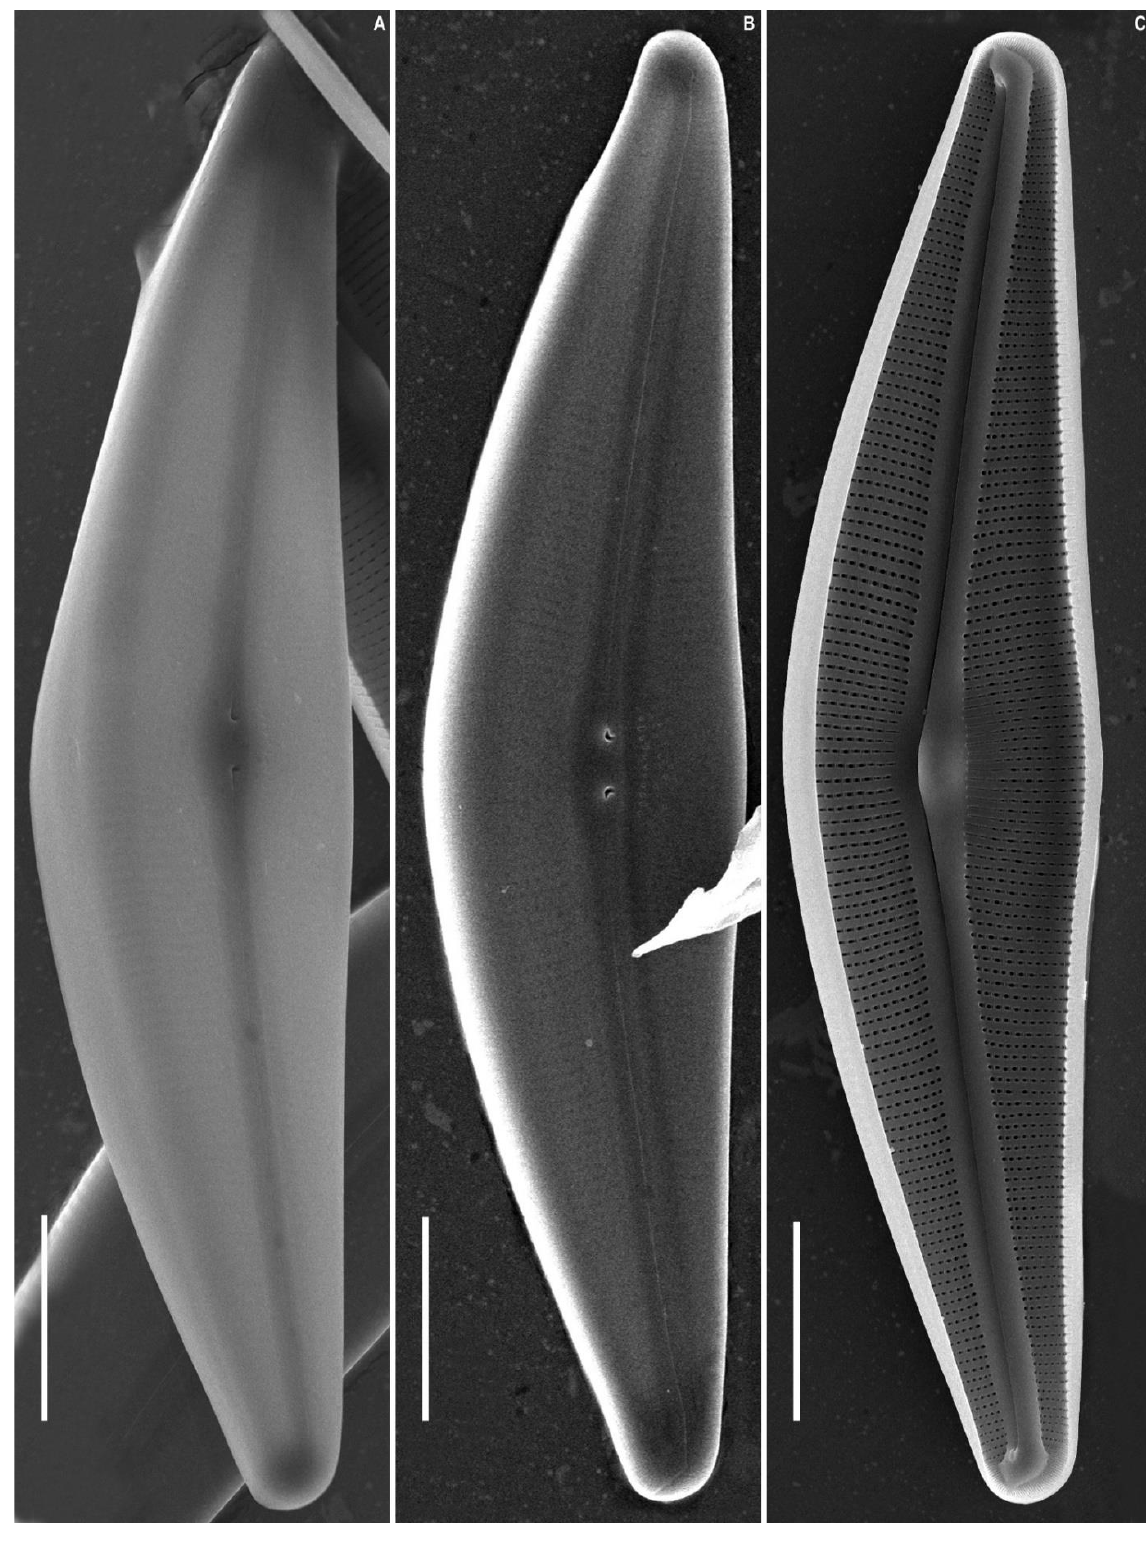
Figure 6. Cymbella baicalaspera Glushchenko, Kulikovskiy and Kociolek sp. nov. Strain B207. Scanning electron microscopy. ( A,B ) External views . ( C ) Internal view. Scale bars = 20 μm.